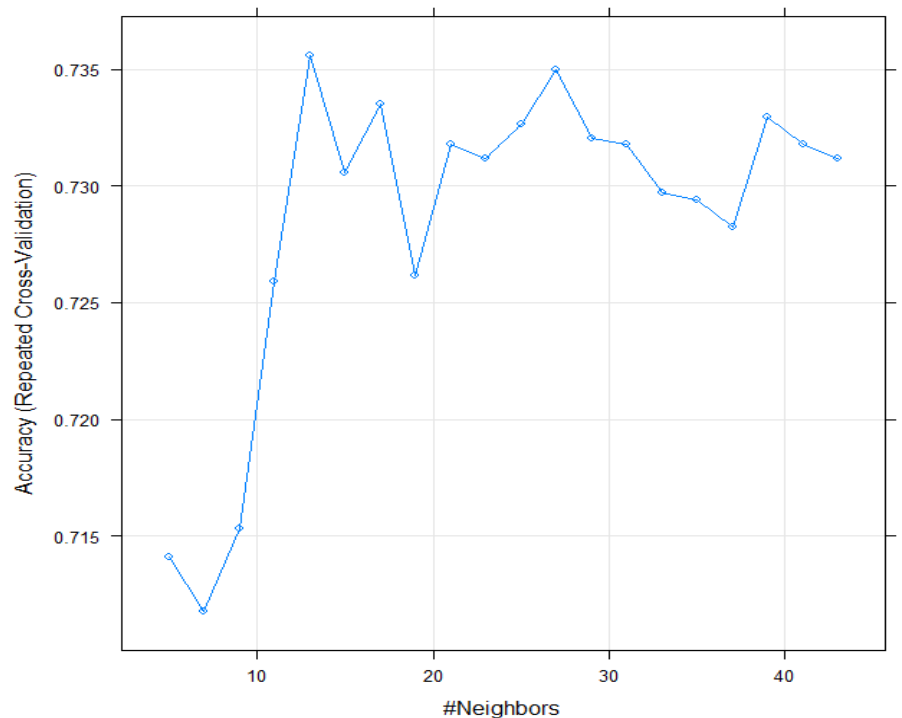
Figure 5. The results of cross-validation in the KNN model.